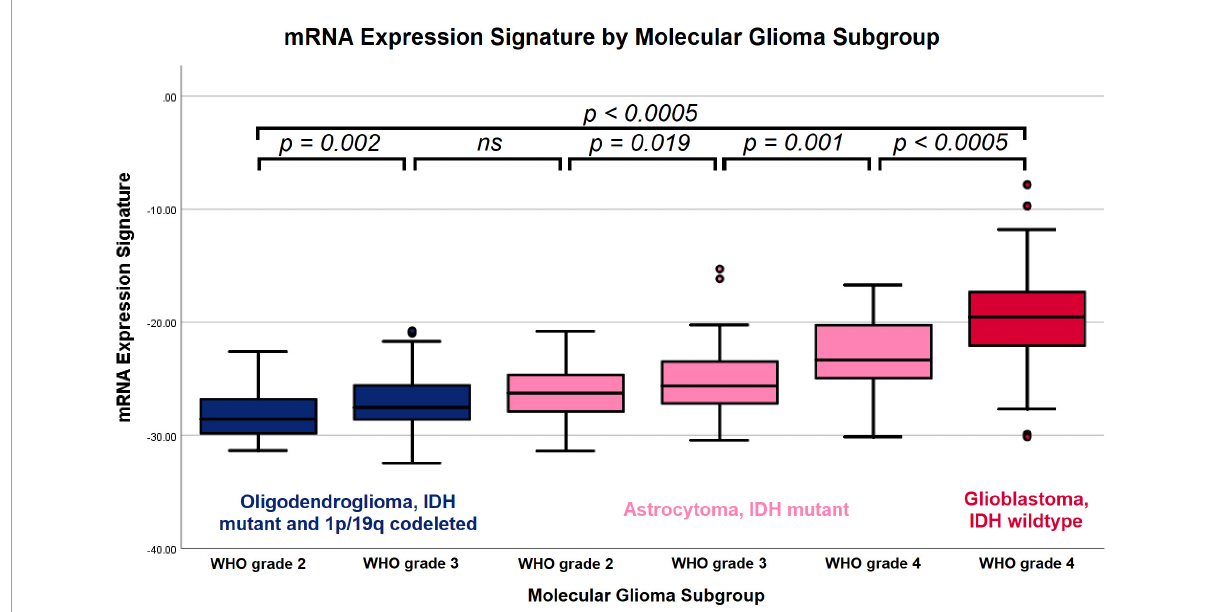
FIGURE4 Boxplot of mRNA expression signature by molecular glioma subgroup. Increasing mRNA expression signatures were observed in IDH mutant and 1p/19q codeleted oligodendrogliomas WHO grade 2, IDH mutant and 1p/19q codeleted oligodendrogliomas WHO grade 3, IDH mutant astrocytomas WHO grade 2, IDH mutant astrocytomas WHO grade 3, IDH mutant astrocytomas WHO grade 4 and IDH wild type glioblastomas WHO grade 4. The overall differences between the subgroups and the between all individual subgroups except for oligodendrogliomas WHO grade 3 vs. IDH mutant astrocytomas WHO grade 2 were statistically significant.